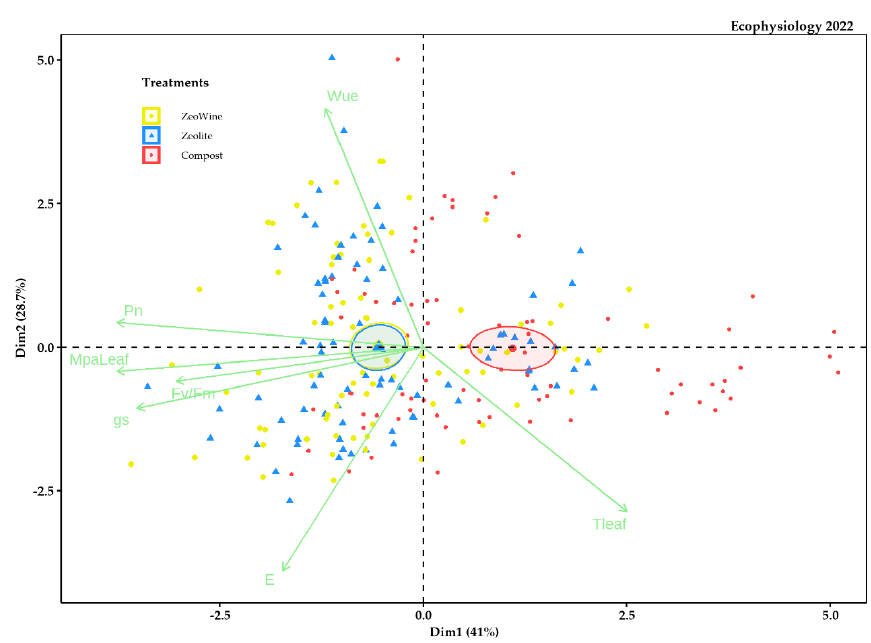
Figure 10. PCA ecophysiology 2022 season. PCA of the following variables (20 May, 13 June, 27 June, 4 July, 18 July, 4 August, 17 August, and 5 September): stem midday water potential, net photosynthesis, transpiration, leaf temperature, stomatal conductance, the fluorescence of chlorophyll, and water use efficiency. The Zeowine and zeolite treatments were to the left part of the distribution and neg- atively related to PN and eWUE and positively related to TLeaf (Dim1 41.0%). Instead, PC 2 (Dim2) explained 28.7% of the data variability.